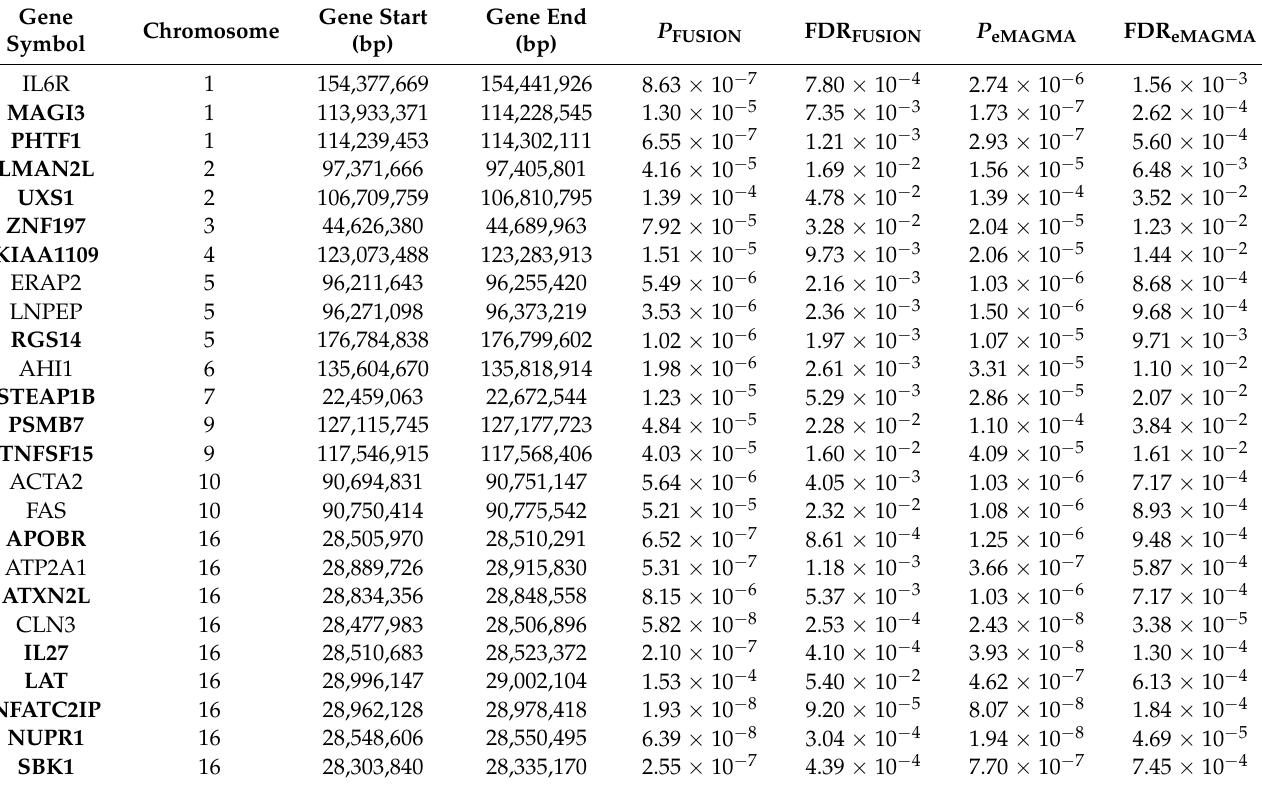
Table 1. Overlapped gene identified by FUSION and